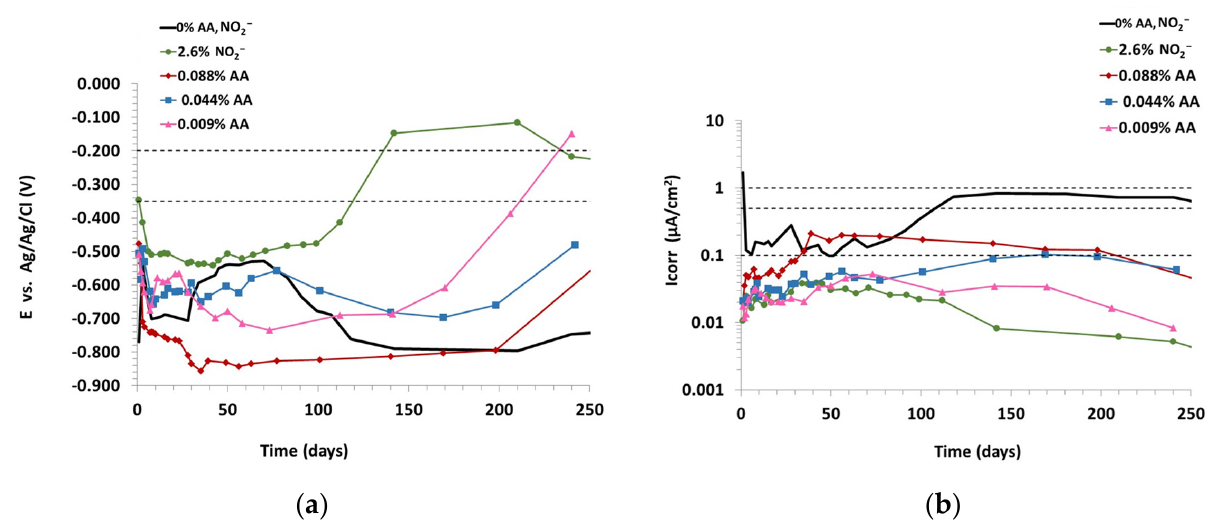
Figure 2. Effect of AA and NO 2 − in chloride-contaminated ( a ) OCP; ( b ) Icorr.